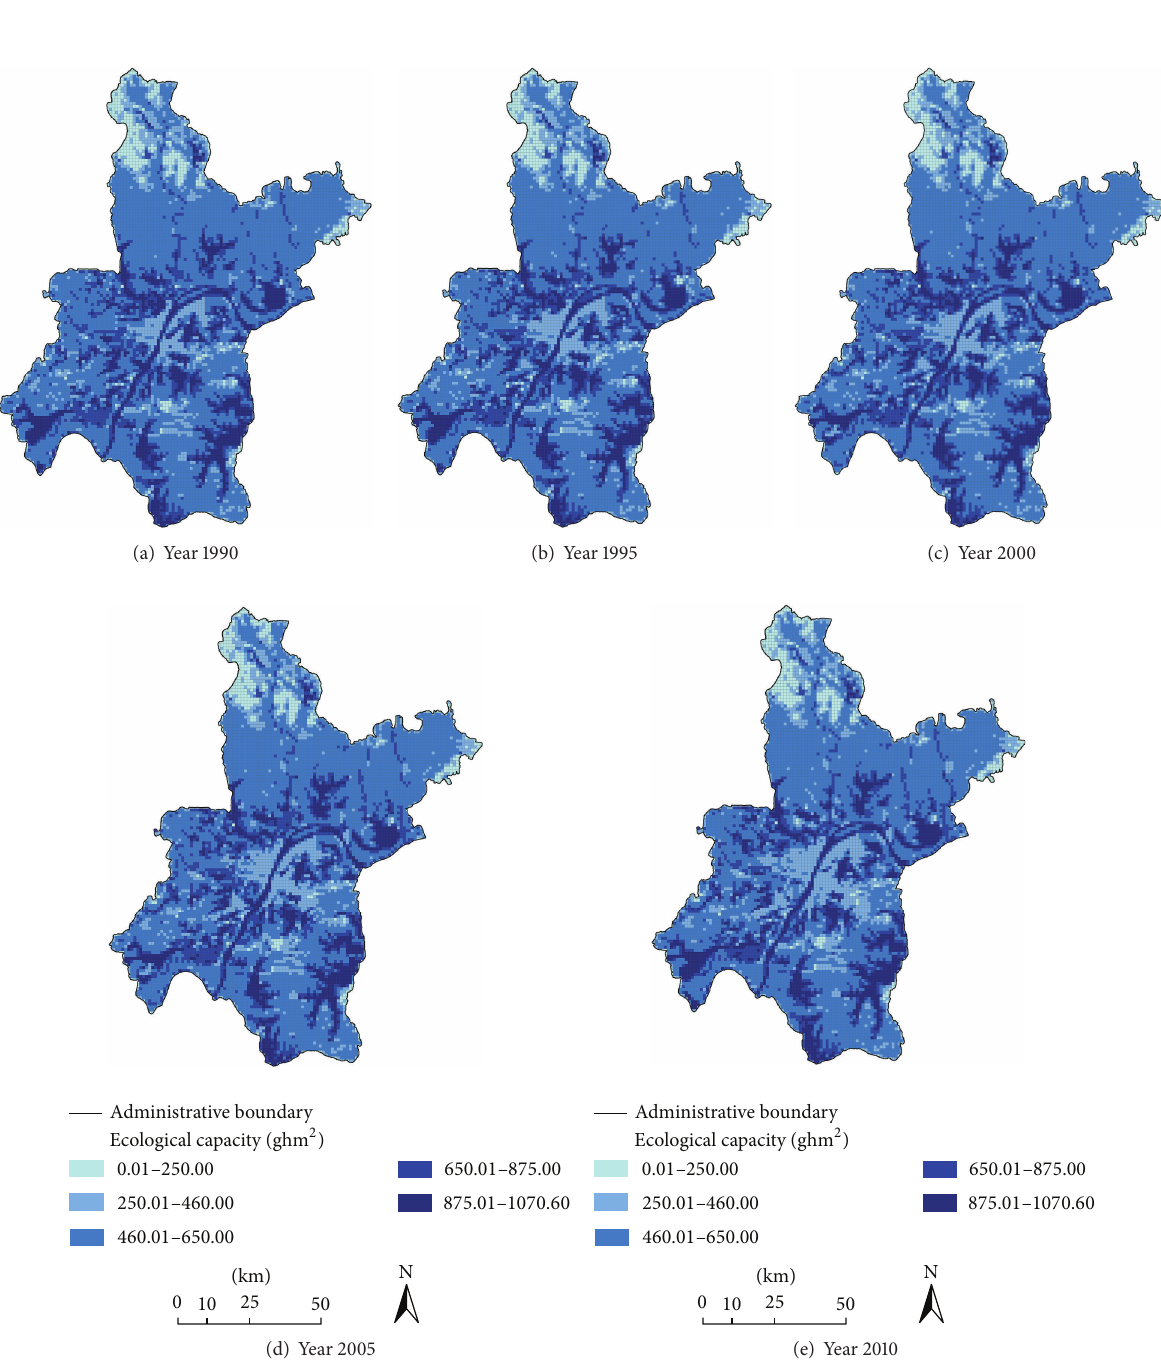
“EC coefficient” and a matrix showing the difference of EC coefficients among different LULC types was built (Table